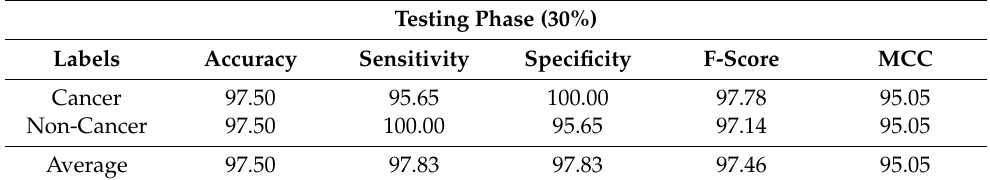
Table 5. Result analysis of OIDCNN-OPMDD approach with distinct class labels under 30% of TS